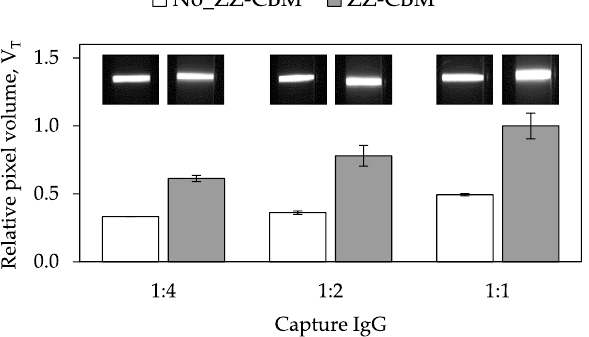
Figure 6. Detection of Cys-C in LFA with capture antibodies anchored on test lines via ZZ-CBM3 fusions and Alexa-labeled Fab. Experiments were performed using analytical strips of NC with a coat of cellulose on the test and control lines. Strips were prepared by dispensing 1:1, 1:2 and 1:4 dilutions of ZZ-CBM3:capture antibody (molar ratio of 1:1.5, 0.5 mg/mL antibody). Controls were also run using LFA with adsorbed capture antibody in the test lines. The pixel volume of test lines, V T , was normalized relatively to the highest pixel volume obtained and plotted as a function of the antibody dilution used. Experiments were performed in triplicate. The inset fluorescence images of the test line region were obtained with the ImageQuant